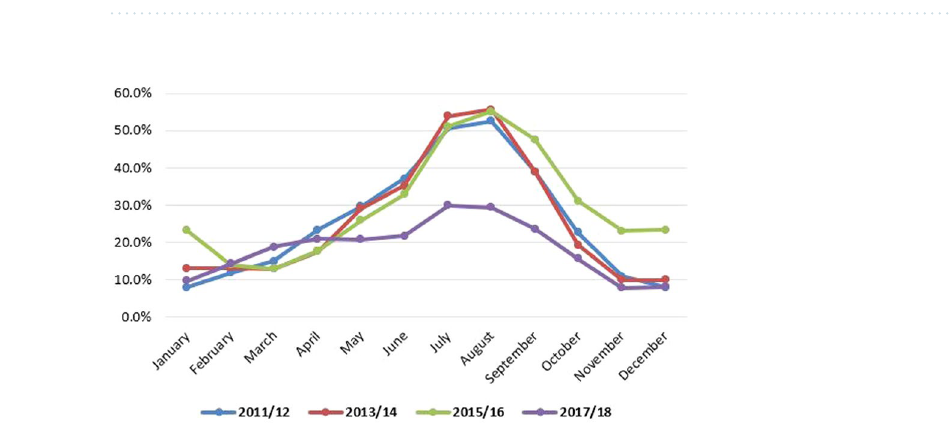
Figure 2. Dynamics of household level food insecurity over the